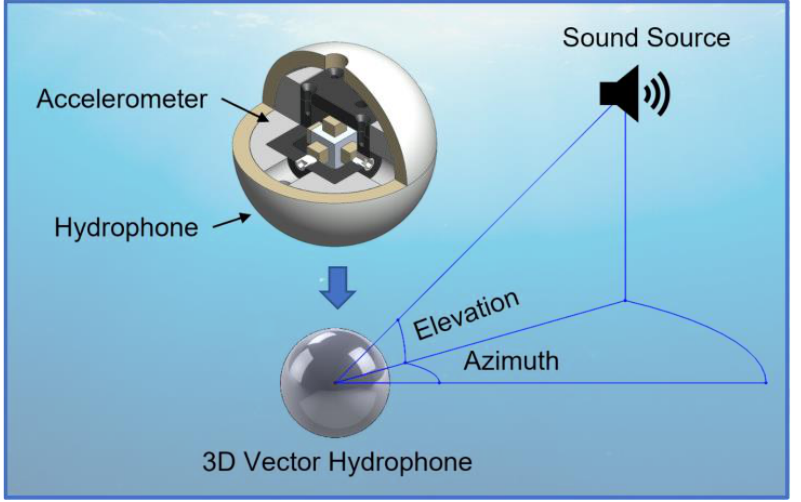
Figure 1. Schematic illustration of a three-dimensional vector hydrophone equipped with a triaxial accelerometer.